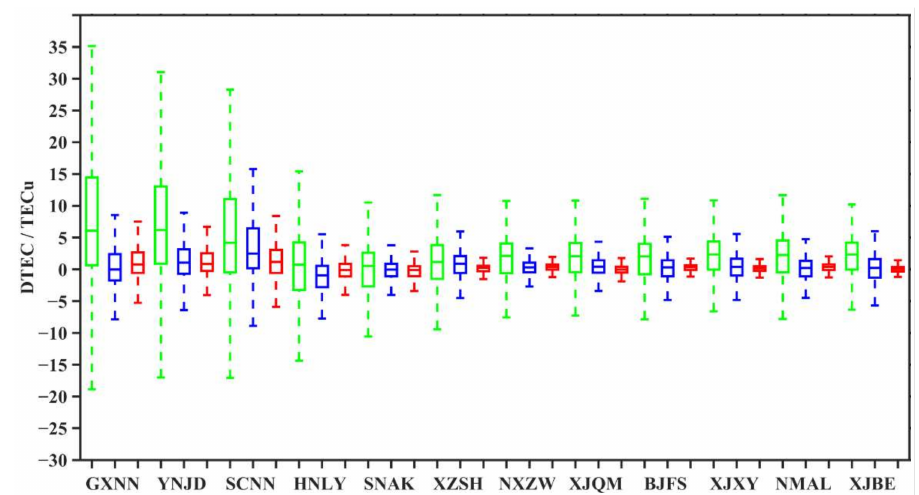
Figure 7. Boxplots of the differences (DTEC) between GNSS-TEC and the TEC estimates calculated using the original IRI-2016 model, scheme A and scheme B at 12 verification stations in 2015 (green, blue, and red boxes correspond to IRI-2016, scheme B and scheme A, respectively).